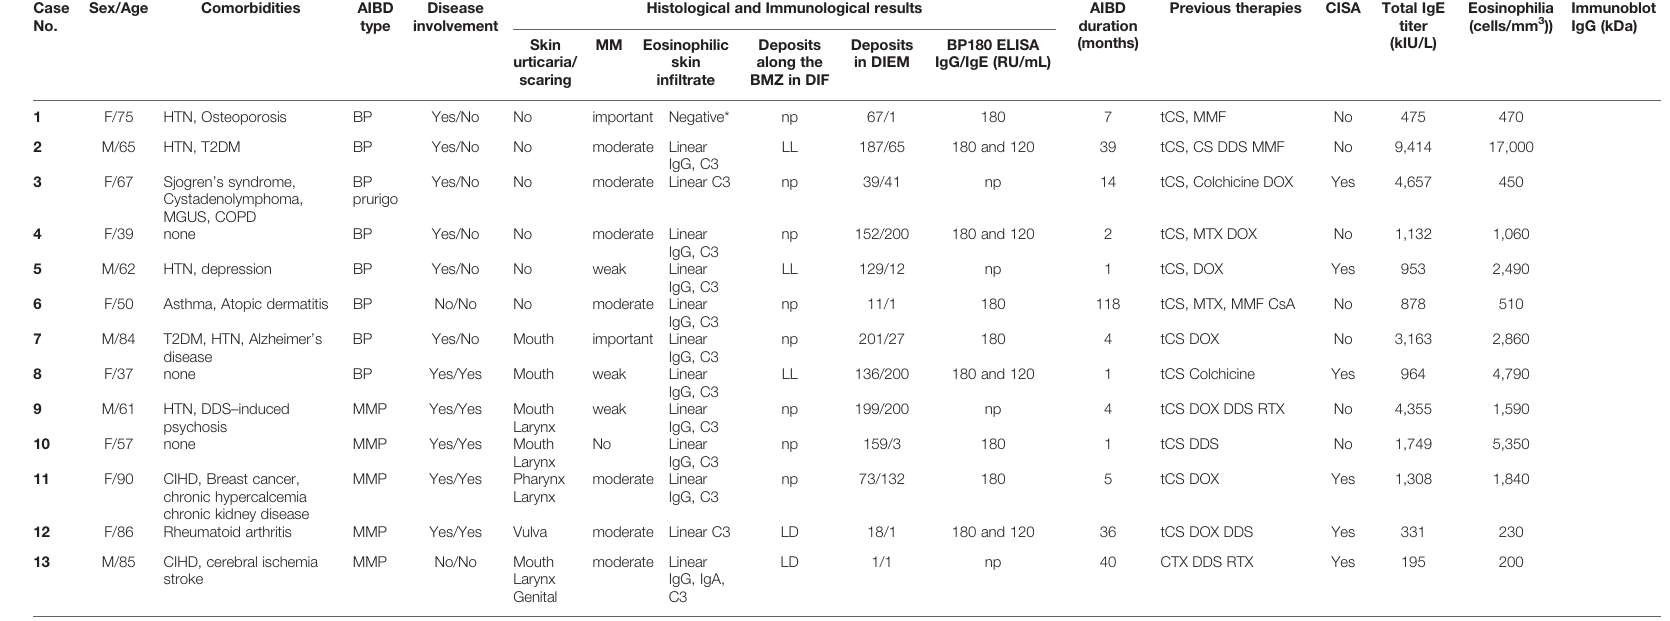
* Under topical corticosteroids. AIBD, autoimmune bullous disease; BP, bullous pemphigoid; CISA, contraindication to immunosuppressive agent; CIHD, chronic ischemic heart disease; COPD, chronic obstructive pulmonary disease; CS, systemic corticosteroids (0.5 – 1.0 mg/kg/d); CsA, cyclosporin;DDS,dapsone;DIEM,directimmunoelectronmicroscopy;CTX,cyclophosphamide;DOX,doxycycline;HTN,hypertension;ISA,immunosuppressiveagent;MGUS,monoclonalgammopathyofundeterminedsigni fi cance;MM,mucousmembrane; MMP, mucous membrane pemphigoid; MMF, mycophenolate mofetil; MTX, methotrexate; np, not acquired; OMZ, omalizumab; T2DM, type 2 diabetes mellitus; tCS, high potent topical corticosteroids (30 – 40